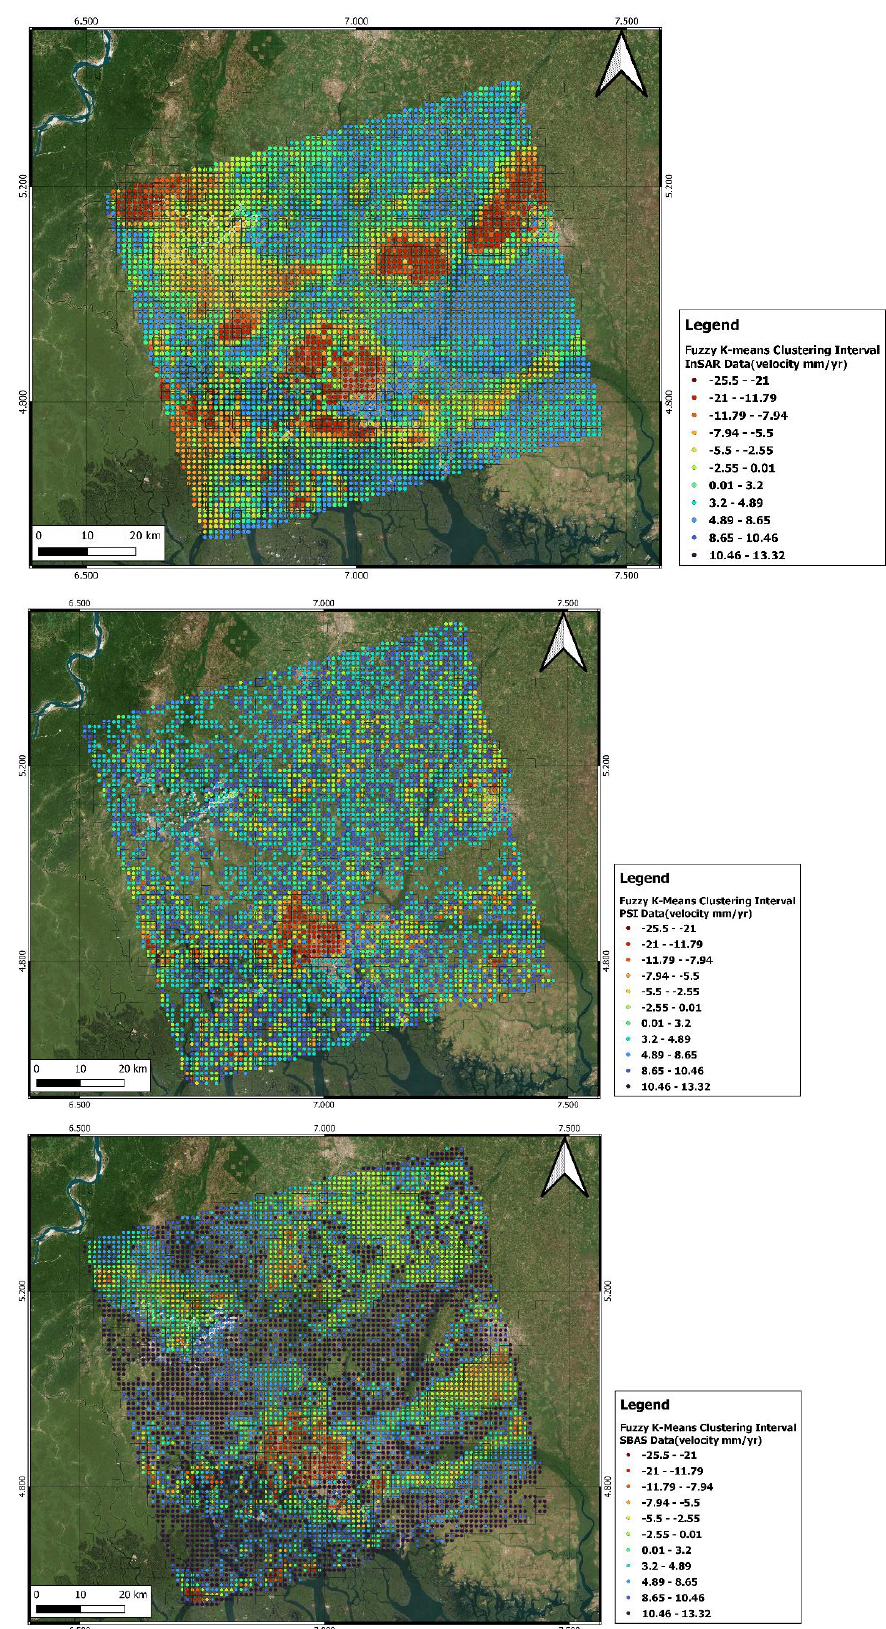
Figure 11. Obtained mean displacement rate maps from different interferometric techniques, includ- ing ( up ) InSAR, ( mid ) PSI, and ( down ) SBAS, by applying the fuzzy K-means clustering algorithm.